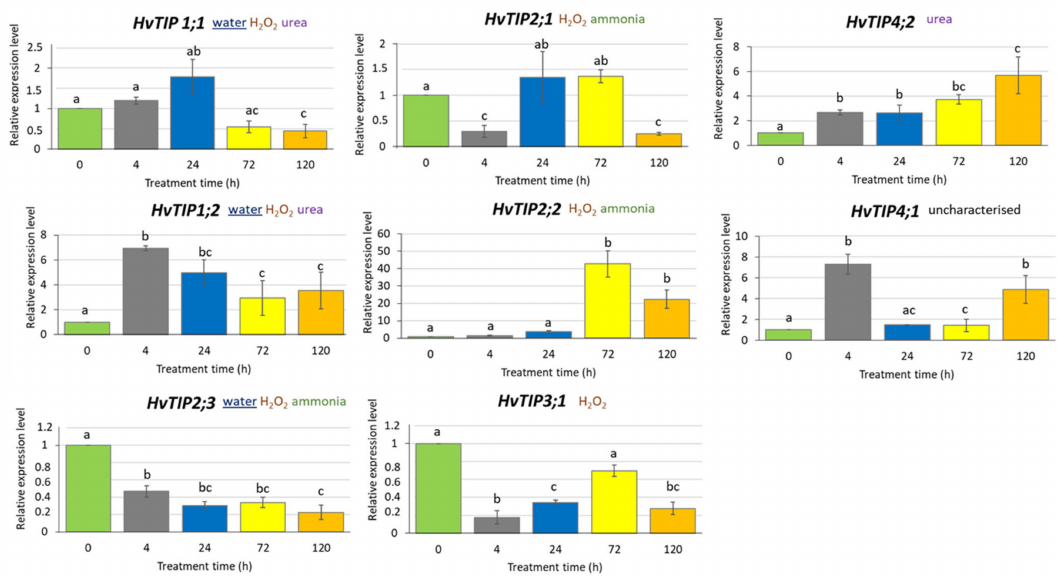
Figure 5. Expression profiles of HvTIP genes in leaves of barley seedlings treated with 500 µ M MeJA in a mini-hydroponic system. The chosen potential substrate or substrates transported by HvTIPs were indicated [52]. The underlined substrate has been experimentally proven for barley HvTIPs [49]. The relative gene expression level in MeJA treated plants was normalised to the control plants grown in a 1 Hoagland’s solution. The statistical analysis was performed using a one-way ANOVA followed 2 by the Fisher Least Significant Di ff erence (LSD) test. Statistically significant di ff erences ( p < 0.05) are indicated by di ff erent